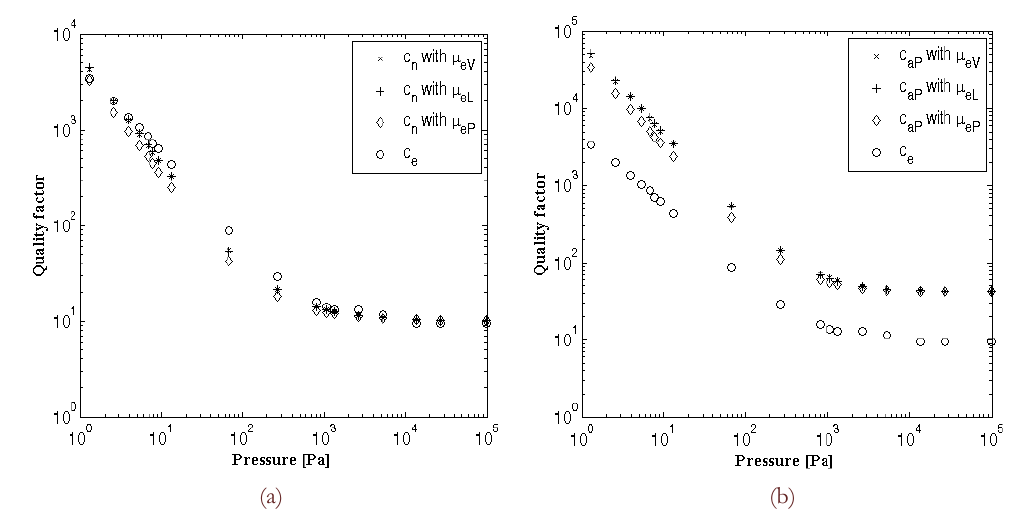
Figure 9: Comparison of the numerical (a) and the analytical results (b) with the experimental data reported by Pandey and Pratap [4]